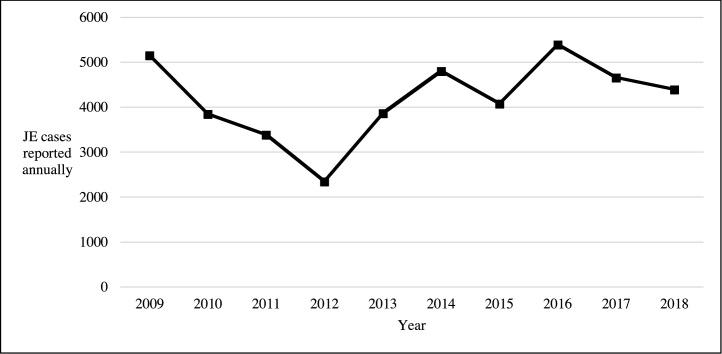
Number of JE cases reported annually over the last decade based on WHO/UNICEF surveillance (World Health Organization, 2019b). Data include probable* and laboratory-confirmed cases reported by JEV endemic countries. *WHO definition of a probable case (Solomon et al., 2008a) = A case that meets the clinical case definition for acute encephalitis syndrome (AES) that occurs in close geographical and temporal relationship to a laboratory-confirmed case of JE, in the context of an outbreak. Note that these data represent only reported cases, and are not considered to be an accurate representation of global JE incidence. The weaknesses of these data are discussed in the main text.